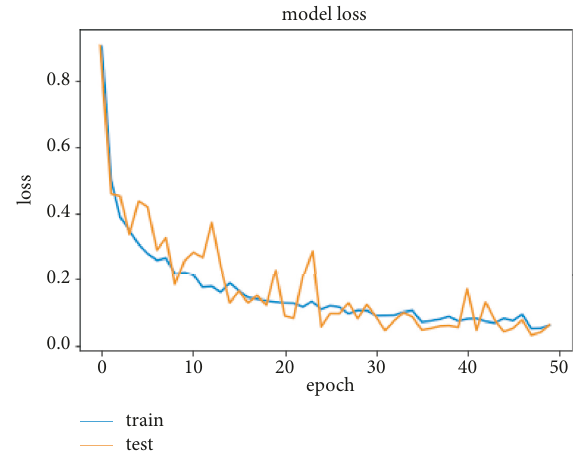
Figure 5: Loss during training and testing the dataset.